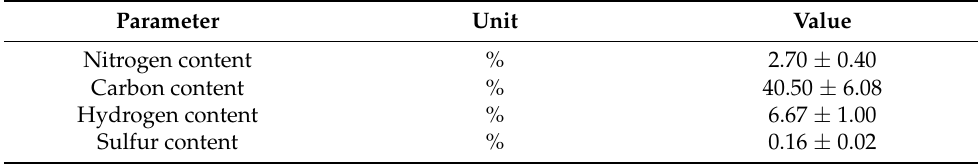
Table 8. Results of the elemental analysis of wheat bran.